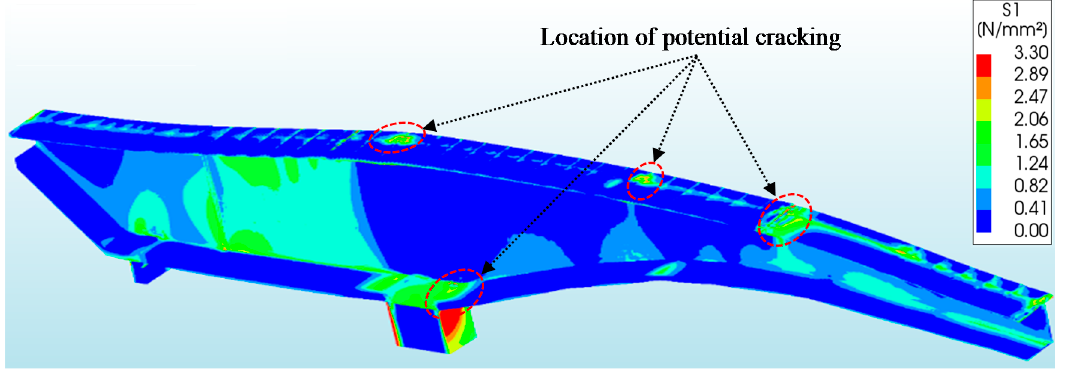
Figure 21. Principal tensile stress of Koror–Babeldaob Bridge on the 160th day.